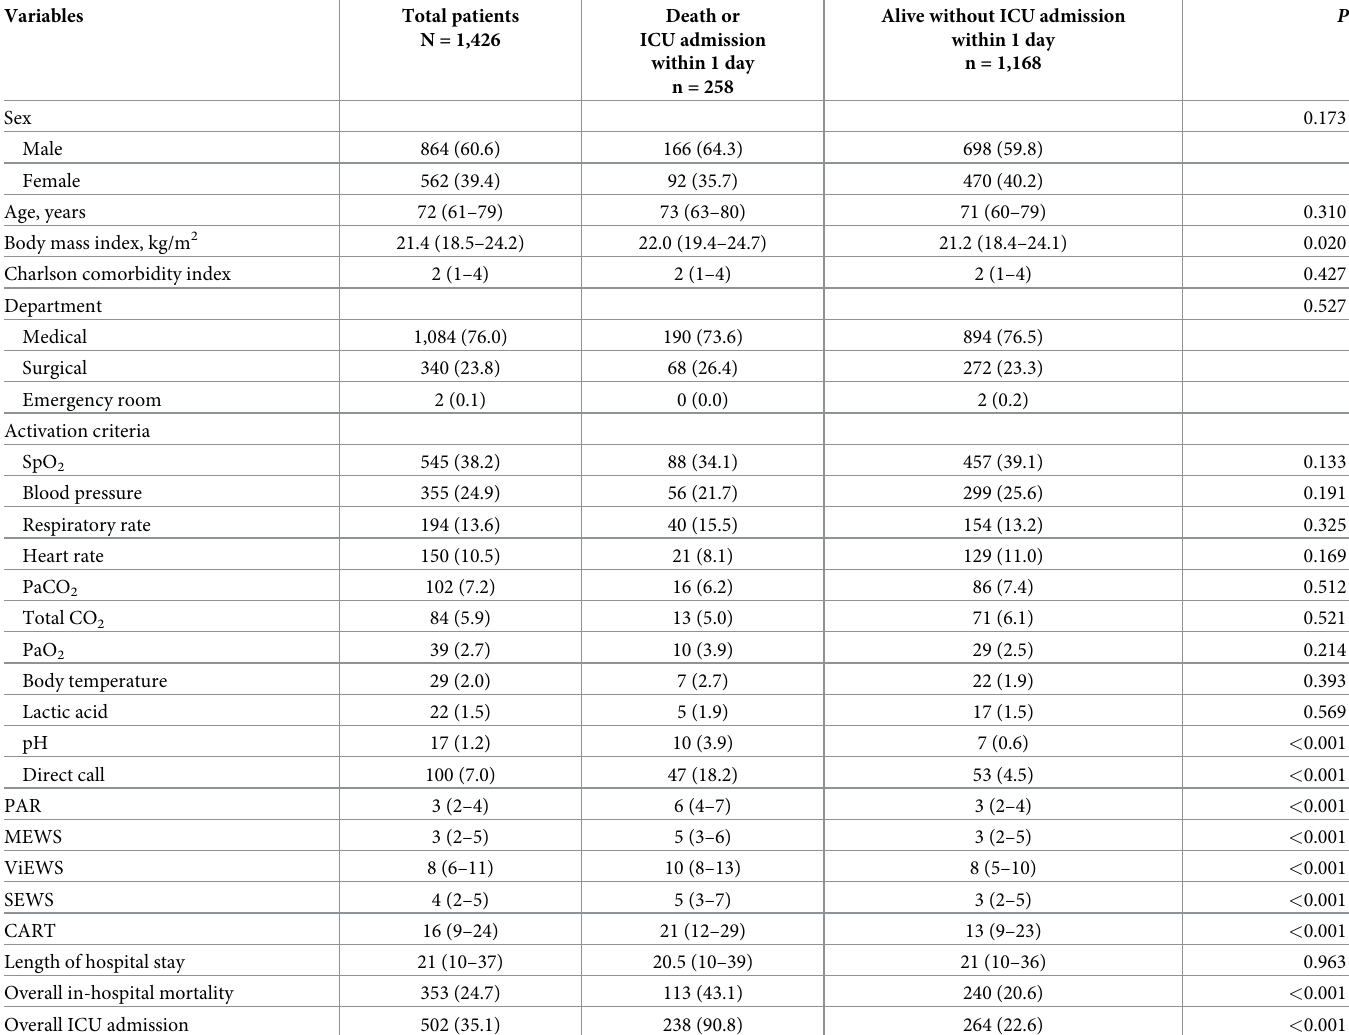
Table 1. Characteristics of patients who were identified using the rapid response